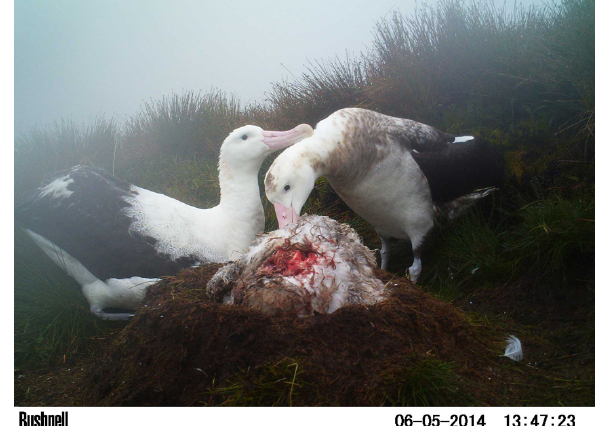
Fig. 5 . Tristan Albatross ( Diomedea dabbenena ) chick failure rate for the years 2008 (n = 161 nests), 2009 (n = 172), 2010 (n = 175), 2012 (n = 192), 2013 (n = 201), and 2014 (n = 149) in the Gonydale study colony. No data for 2011. The shaded area represents the time when chicks are first left